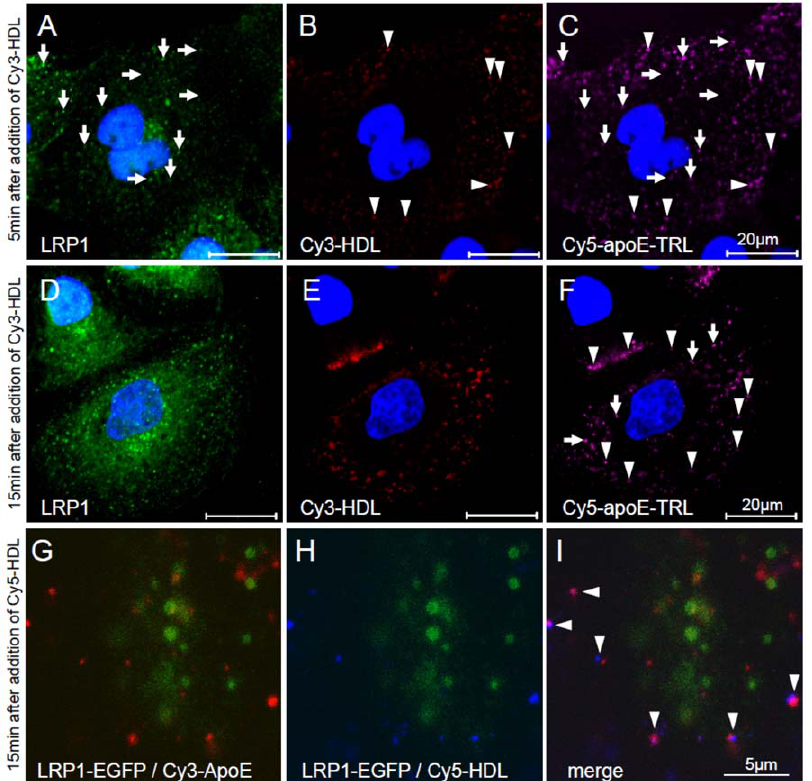
Figure 6. HDL stimulates the exit of apoE from LRP1- containing endosomes. HuH7 cells were incubated with Cy5-apoE-TRL for 20 minutes. ApoE recycling was then induced by Cy3-HDL. After 5 min (A–C) and 15 min (D–F), LRP1 (arrows) did no longer co-localize with Cy5-apoE which was instead found associated with Cy3-HDL (arrowheads; nuclei in blue). This was confirmed by high-magnification video-microscopy of LRP1-EGFP expressing HEK293 cells (G–I; due to short time-lapse between acquisition of red and blue channels, a minor signal offset due to endosomal movements was observed). Bar is 5 (G–I) and 20 m m (A–F), respectively.